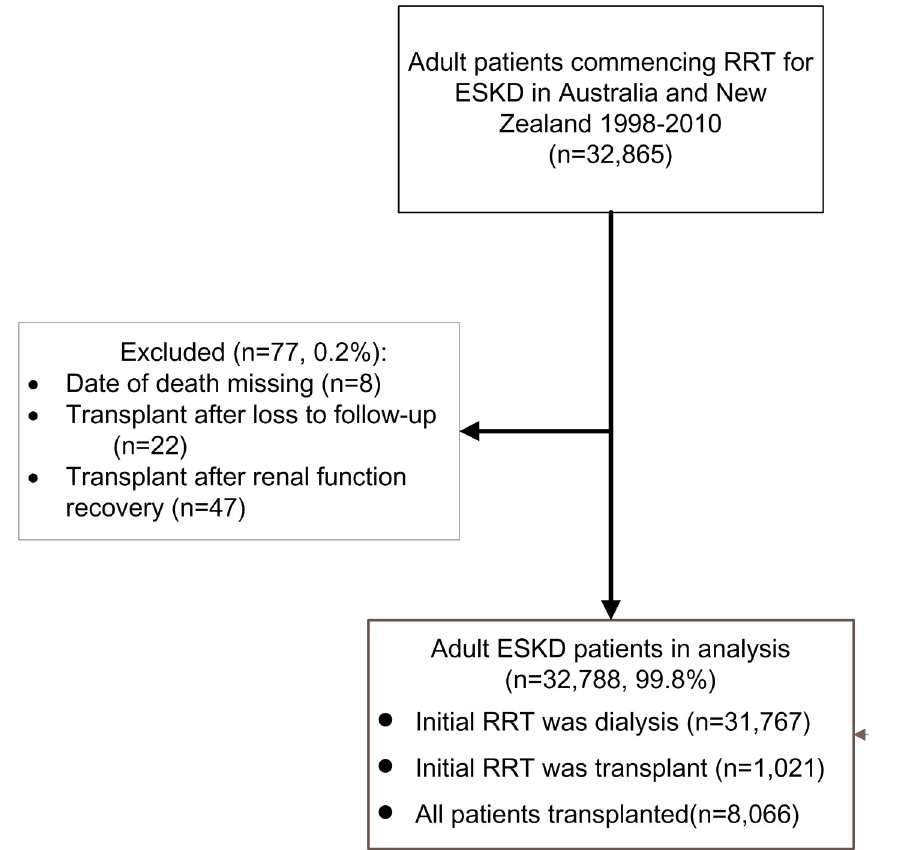
Fig 1. Flow chart. Abbreviations: RRT,Renal replacement therapy. ESKD, End-stage kidney diseases.